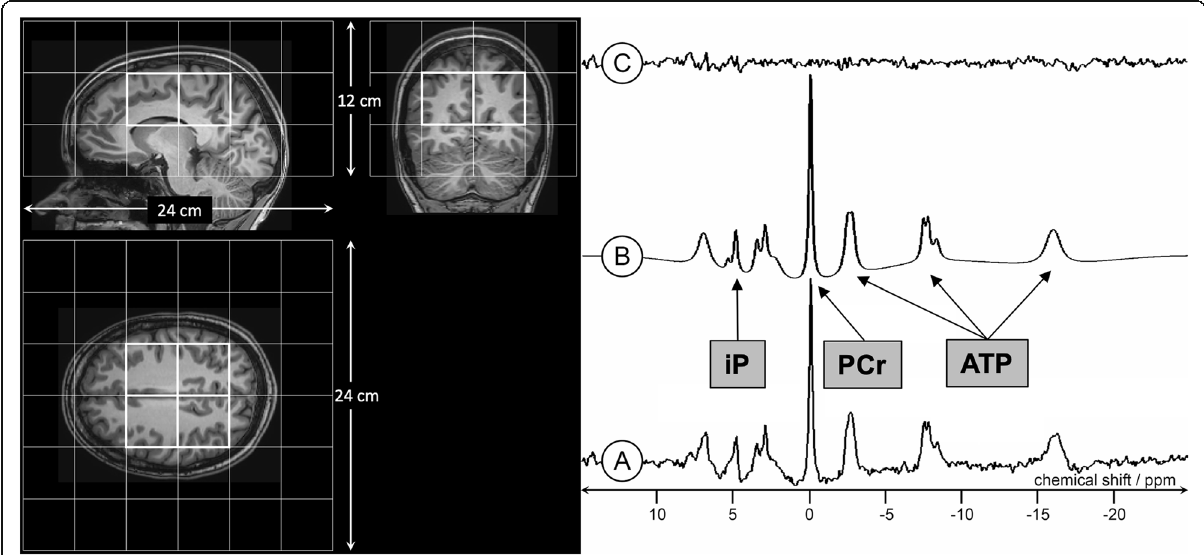
Fig. 3 31P-Magnetic resonance spectroscopy imaging for the assessment of in vivo mitochondrial bioenergetics. 31P-MRSI spectra of a representative subset of brain parenchyma will be taken using a double-tuned P-headcoil (Advanced Imaging Research, Cleveland, Ohio). To attain sufficient relaxation of the phosphorus metabolites, a repetition time of 4500ms will be used together with a three-dimensional chemical shift imaging sequence (6×5×3 voxel, 6kHz bandwidth, 1024 data points, 8:51min measuring time). The analysis procedures will follow an updated version of an already published protocol with an optimization of data acquisition. Peak positions and intensities will be calculated with the AMARES algorithm. We will examine adenosine triphosphate (ATP) and phosphocreatine (PCr), which reflects the overall high-energy phosphate turnover. PCr represents a high-energy reservoir linked to ATP in a bidirectional reaction in which ATP is formed by PCr and vice versa. In addition to PCr and ATP, the ratios of PCr/inorganic phosphate (iP) and ATP/Pi will be evaluated as an indicator of intracellular energy status within the scope of this study. A: 31P-MRSI spectrum. B: model fit on 31P-MRSI spectrum. C: background